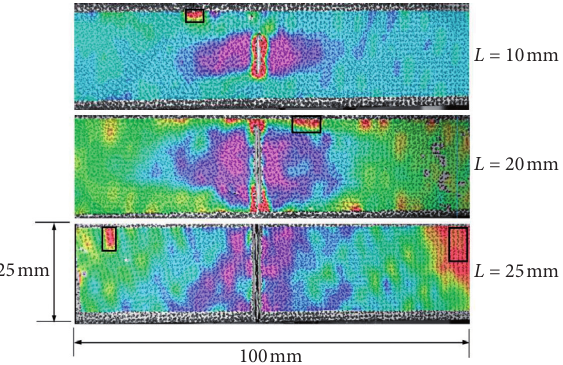
Figure 10: Strain fields ε yy of scratched samples under failure load.